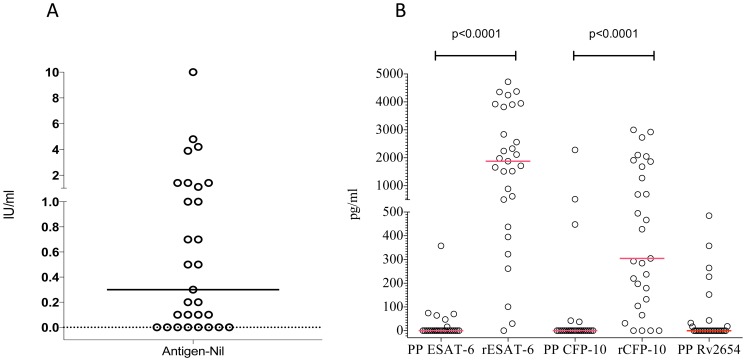
QFT-IT results, representing the Antigen-Nil IU/ml INF-gamma values (n = 29, Panel A).The solid line represents the median. IFN-gamma response to peptide pools (covering ESAT-6, CFP-10, and Rv2654) and recombinant ESAT-6 and CFP-10 in the 7 day WBA (n = 29, Panel B). “PP” indicates peptide pool and “r” indicates the recombinant proteins. Recombinant proteins induced significantly higher responses than the peptide pools (p<0.0001 for both ESAT-6 and CFP-10). IFN-gamma concentrations are shown as pg/ml. Lines indicate median response.